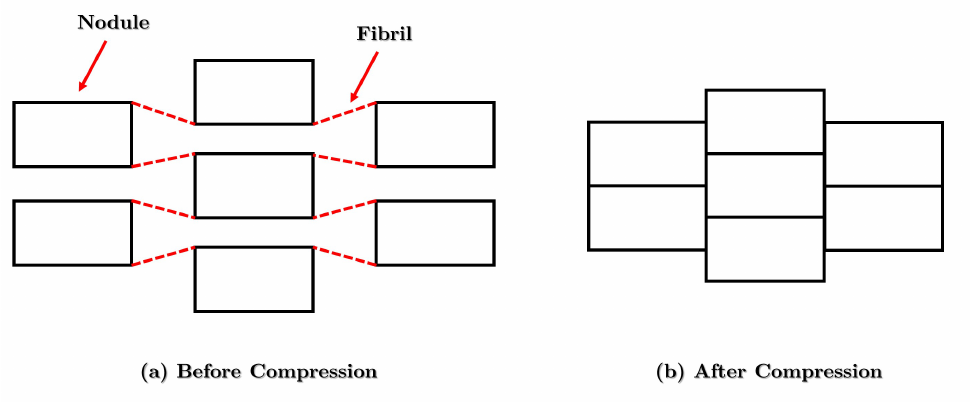
Figure 16. Typical shape of fibril–nodule structures: ( a ) before compression; ( b ) after